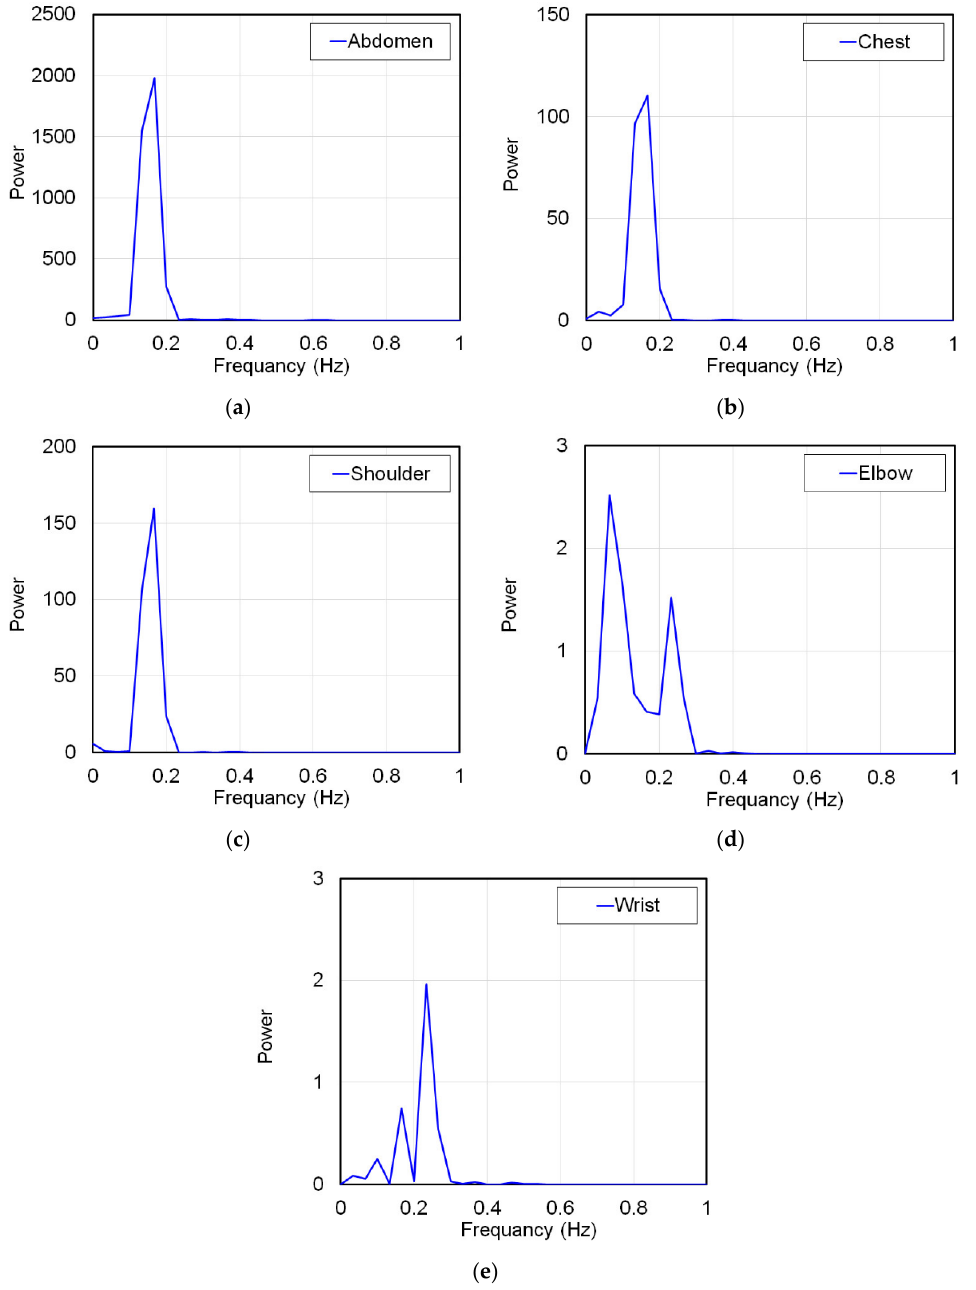
Figure 11. Frequency analysis results by Fourier transform of signals measured at each part of the living body, ( a ): abdomen, ( b ): chest, ( c ): shoulder, ( d ): elbow, ( e ): wrist.